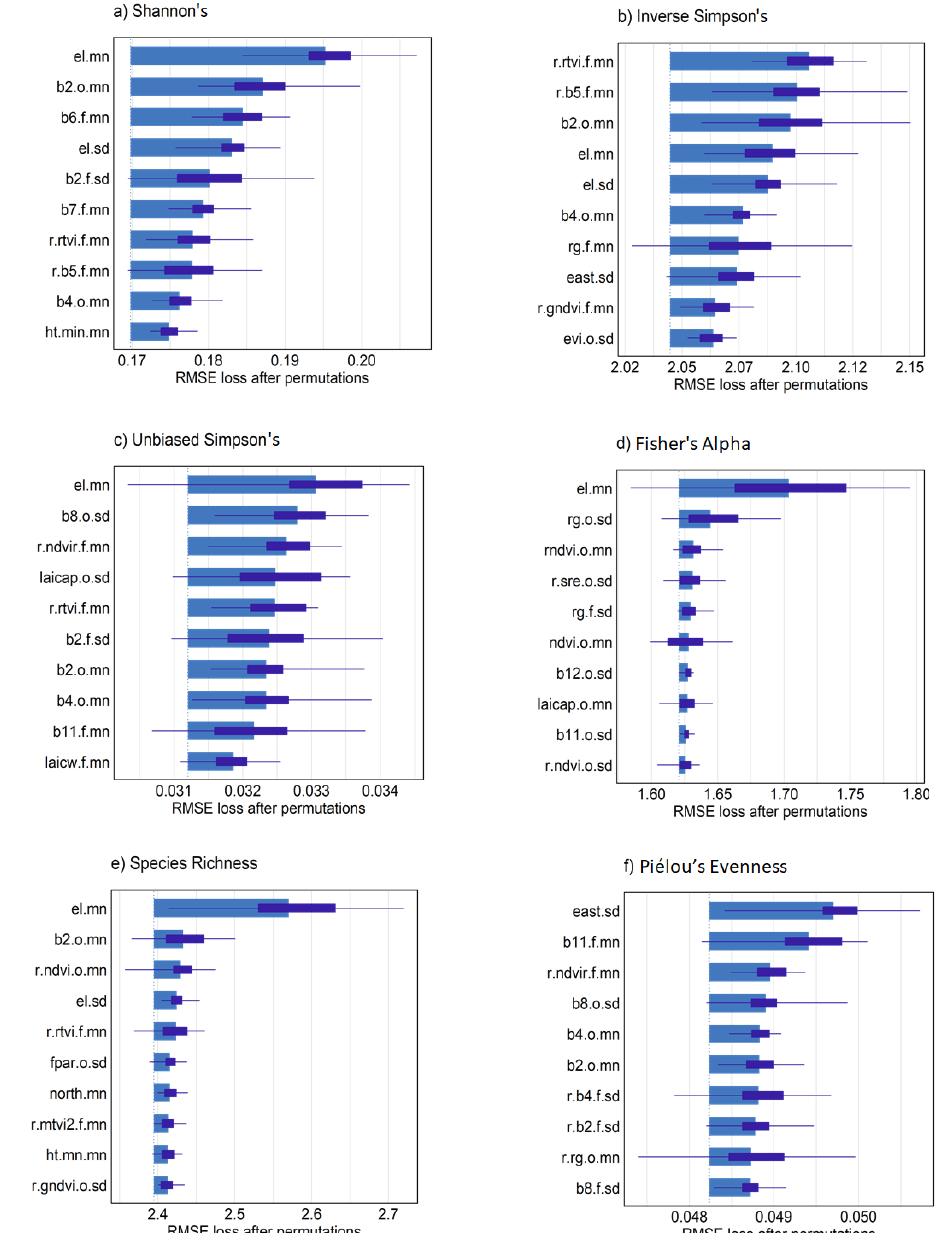
Figure 9. Variable importance plots for combined ensemble models and each α-diversity measure from n = 25 model permutations with test sample data. Predictor variable names beginning with “r.” were developed from RapidEye. A “.o” or “.f” indicated if a predictor is from the leaf-on or leaf-off period respectively. All “ht.” or “el.” are canopy height and elevation predictors. A suffix of “.mn” or “.sd” indicates mean and standard deviation grid cell values,